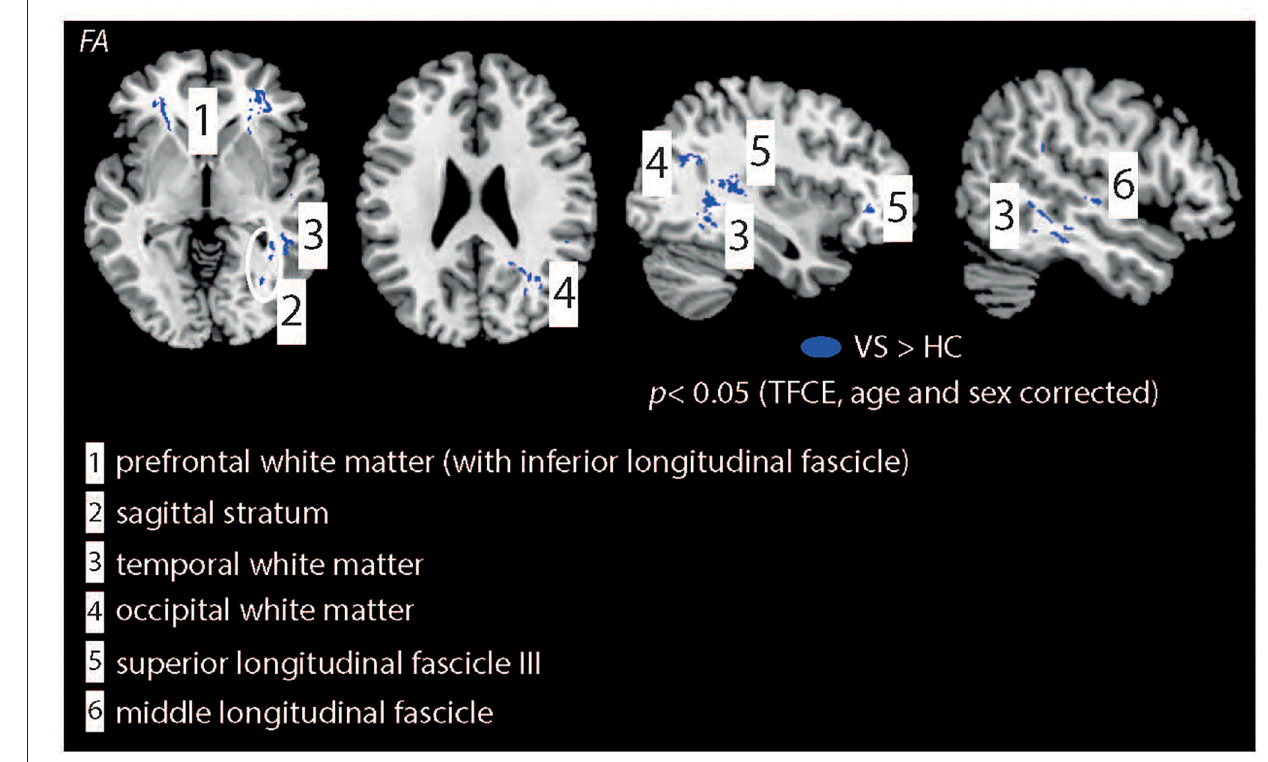
FIGURE 1 | Illustration of WM changes for the statistical comparison “HCs vs. patients with VSS.” Patients demonstrated higher FA values in multiple brain regions. In contrast, HC showed higher MD and RD values compared to patients with VSS (not shown, see Table 2 ). All results are TFCE, age and sex corrected. IFOF, Inferior Fronto-Occipital